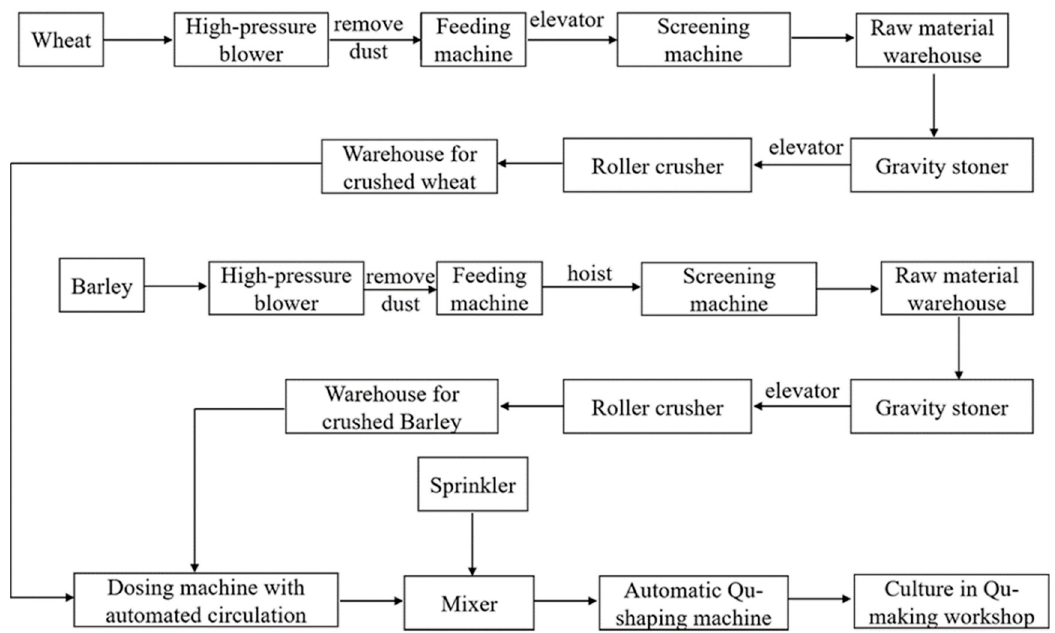
Figure 3. Intelligent Koji-making system for the production of Daqu for Nong-flavor Baijiu, adapted from reference [12].